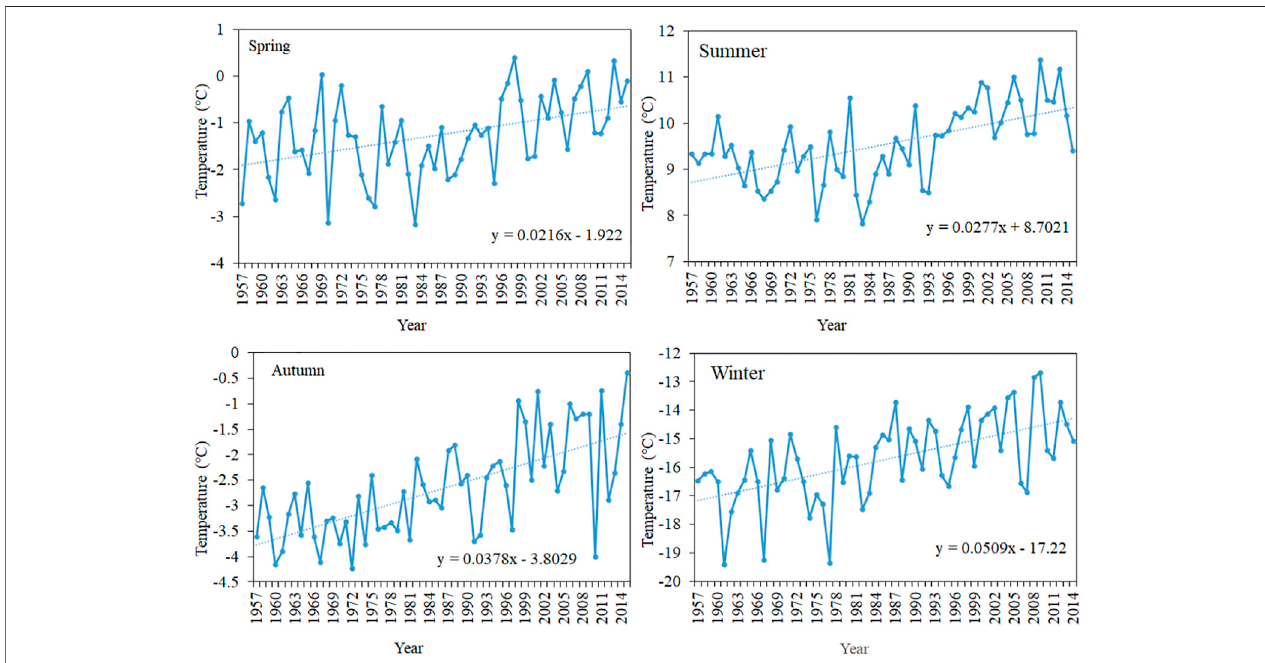
FIGURE 8 | Seasonal temperature variation of Tuole meteorological station, 1957 –